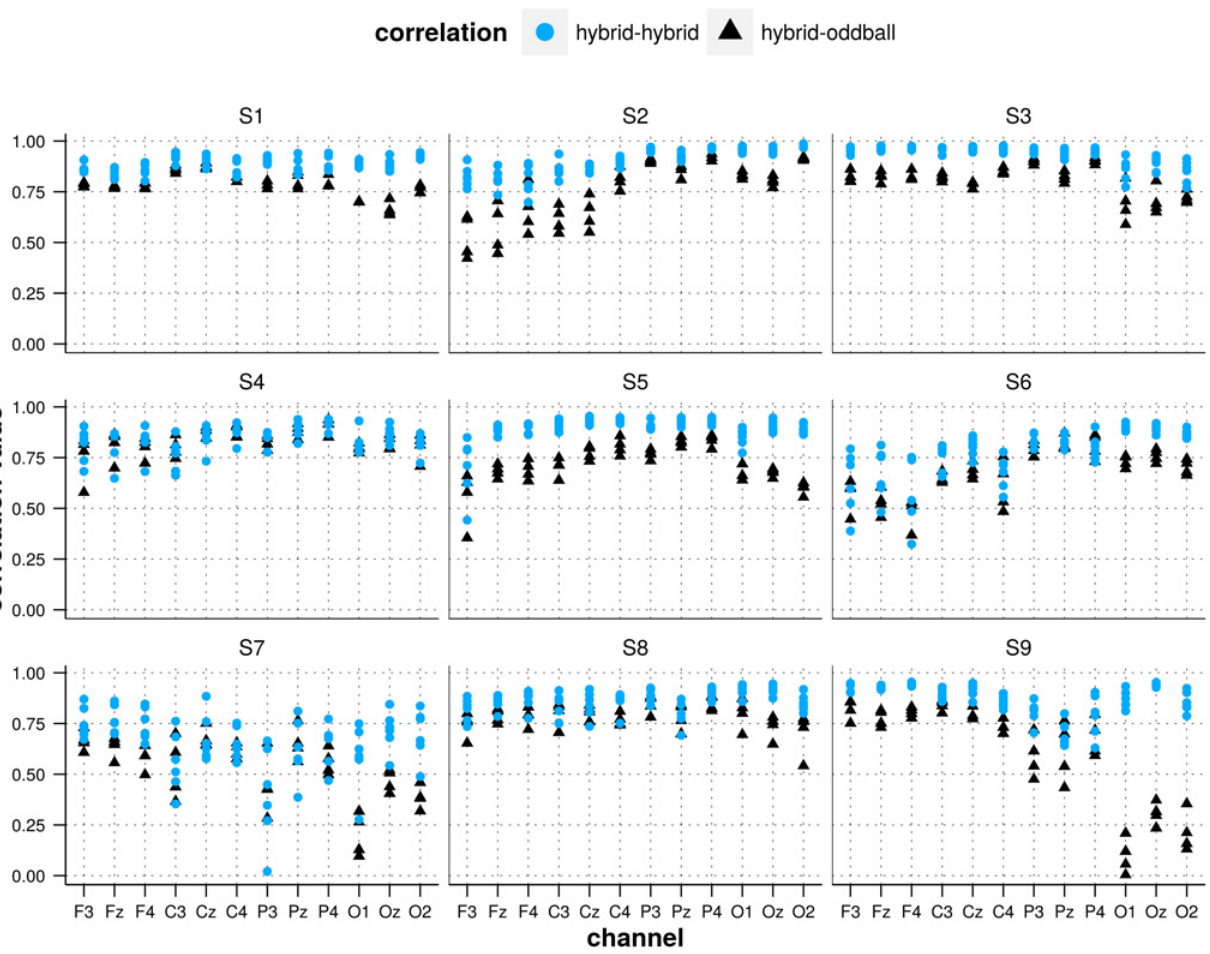
Fig 5. Pairwise correlations between ERPs for all conditions per subject and EEG channel. The triangles (blue) represent correlation values measured between the average ERP recorded in the oddball condition and the average ERP recorded in each of the 4 hybrid conditions while the dots (red) represent correlation values measured between 2 average ERPs recorded in different hybrid